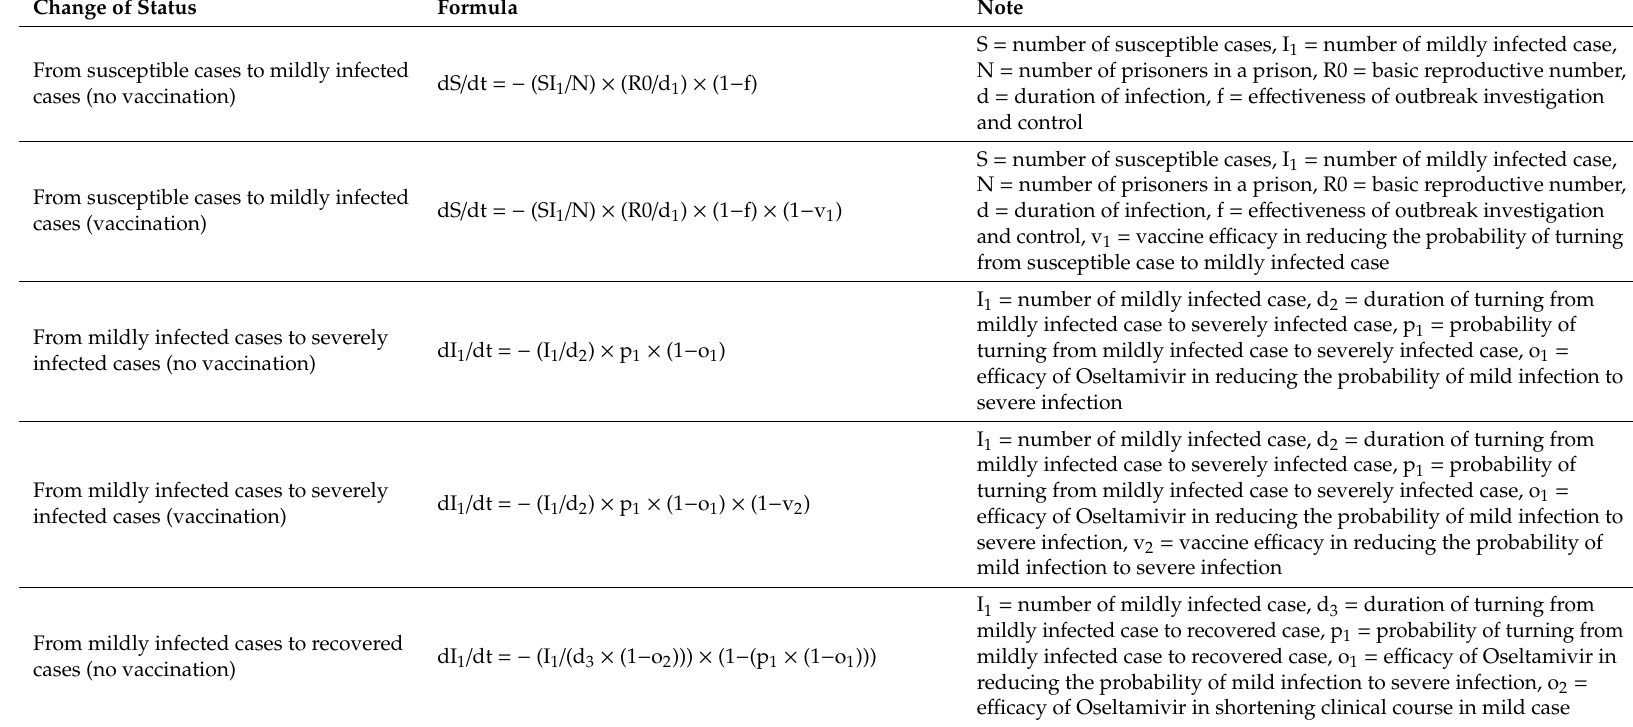
Table 3. Key formula used in the